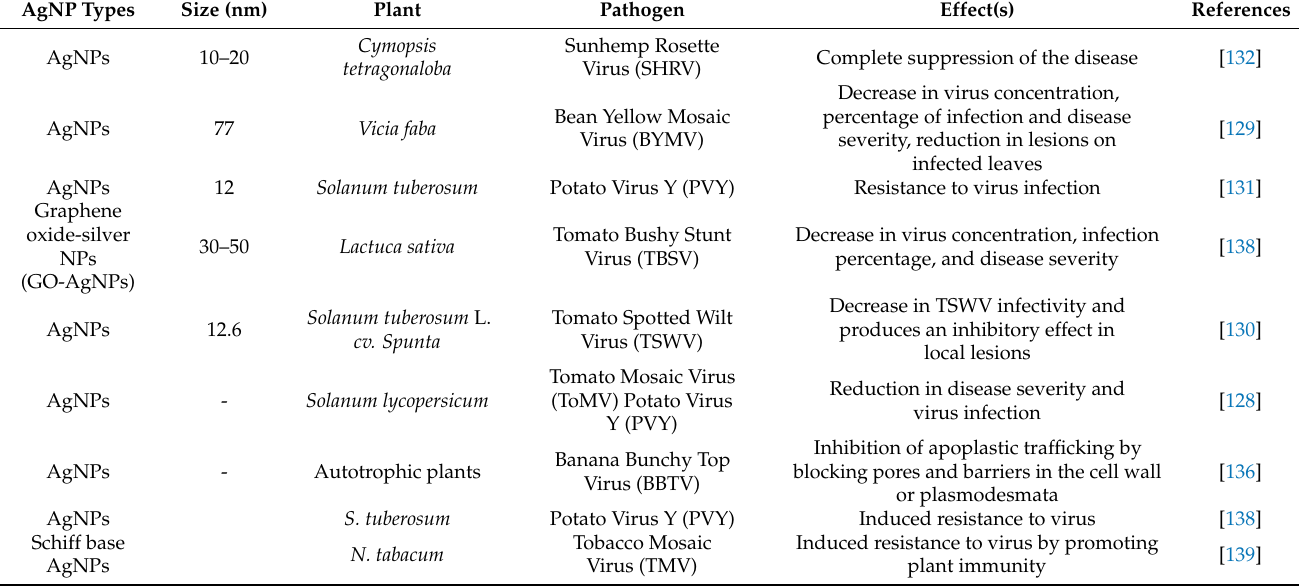
Table 5. AgNPs in viral disease